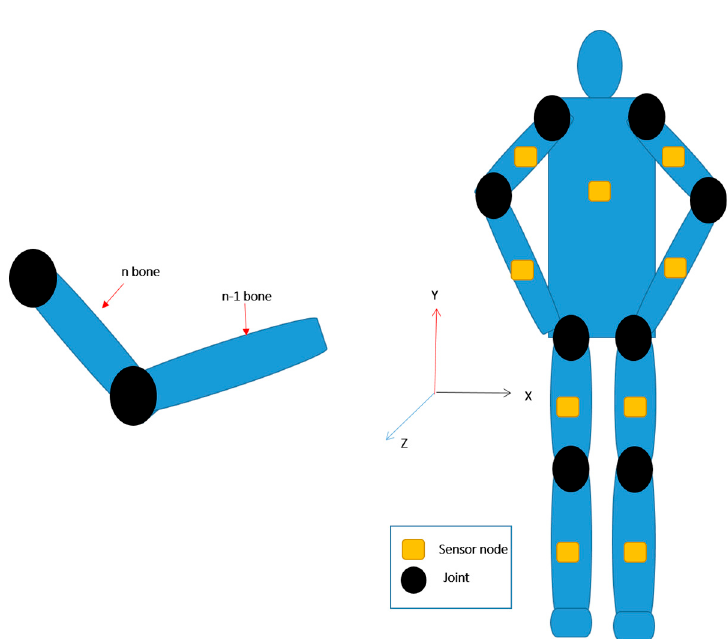
Figure 14. The kinematic chain of a human body.